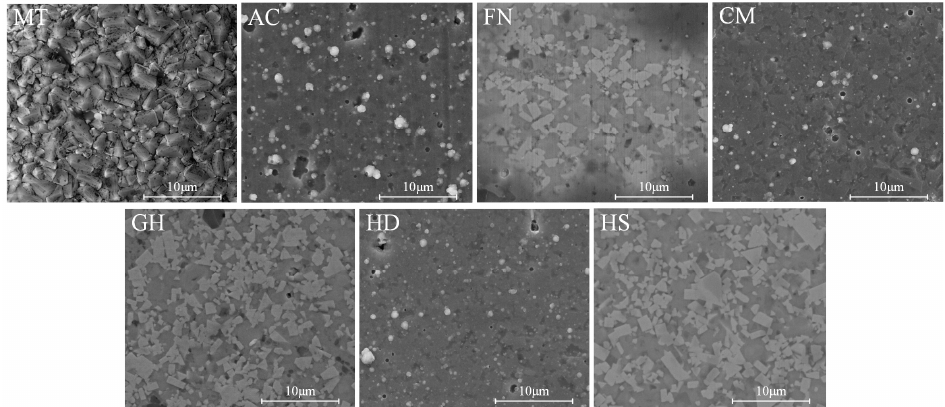
Figure 4. Images of the morphology of the coating surfaces.